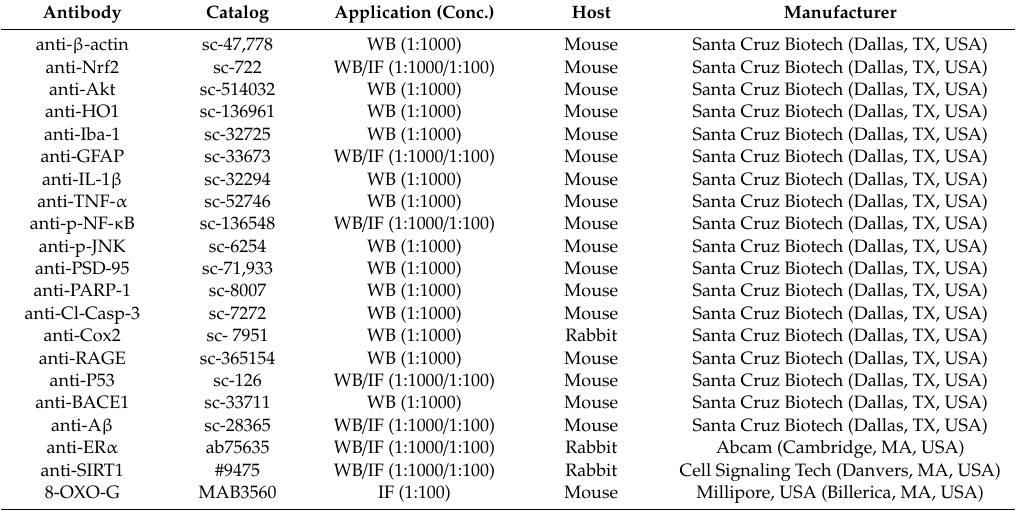
Table 1. List of primary antibodies and their information used in this